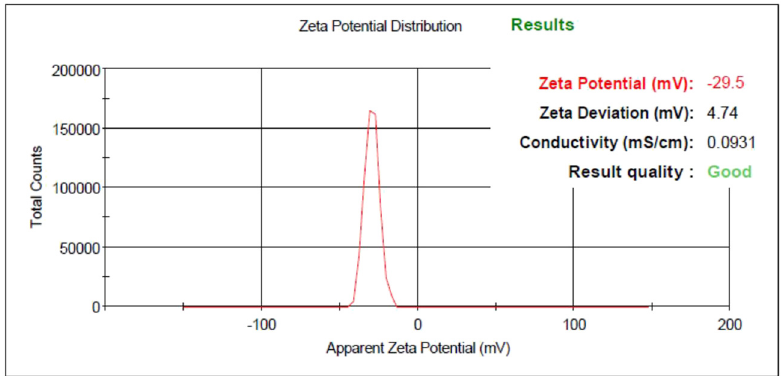
Figure 6: Surface charge ( zeta potential ) value of NSS, adapted from ref. [ 13 ]